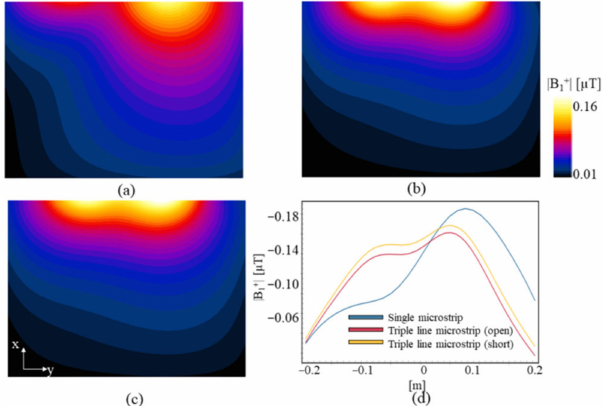
Figure 2. The computed |B 1 + |-field for ( a ) a single microstrip, ( b ) the triple-line microstrip transmis- sion line (t-MTL) with open circuit terminated, and ( c ) the triple-line microstrip with one line short circuited, and the field profile ( d ) for each of the computed |B 1 +